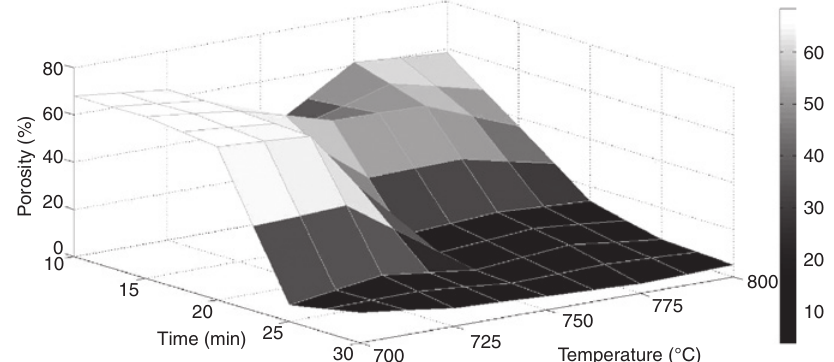
Figure 6: MG80 porosity as a function of sintering time and temperature.